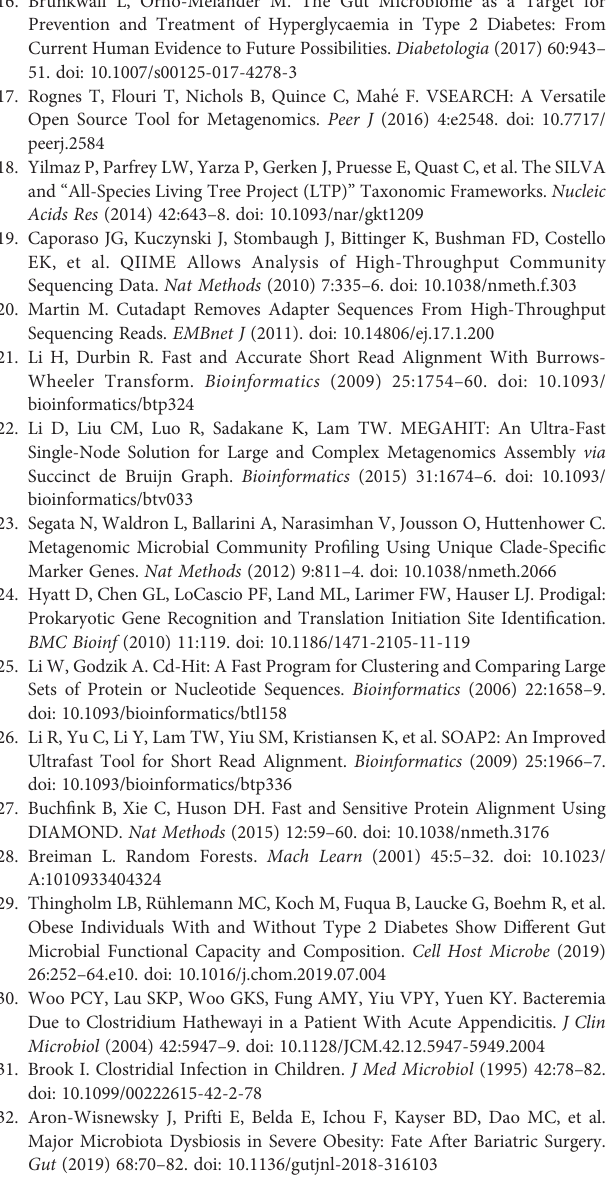
Supplementary Figure 6 | NMDS analysis based on the Bray-Curtis distance of top-ranked depleted geneabundance in Ob&T2D. (A – D) , NMDS analysis based on the Bray-Curtis distance of top N (N = 100, 200, 500 and 1000) depleted genes abundance in Ob&T2D. Anosim R and P values are shown as indicated. Supplementary Figure 7 | NMDS analysis based on the Bray-Curtis distance of top-ranked enriched gene abundance in Ob&T2D. (A – D) , NMDS analysis based on the Bray-Curtis distance of top N (N = 100, 200, 300 and 500) enriched genes abundance in Ob&T2D. Anosim R and P values are shown as indicated. Supplementary Figure 8 | Redundancy analysis(RDA) illustrating the relationship between clinal characteristics and microbial gene community. RDA analysis based on the abundance of top 300 depleted genes in Ob&T2D illustrating the relationship between clinical indices and microbial gene community. Glu: glucose level; HbA1c: Hemoglobin A1c; Mono: monocyte; ANC, neutrophils; WBC, white blood cell; LYMPH,